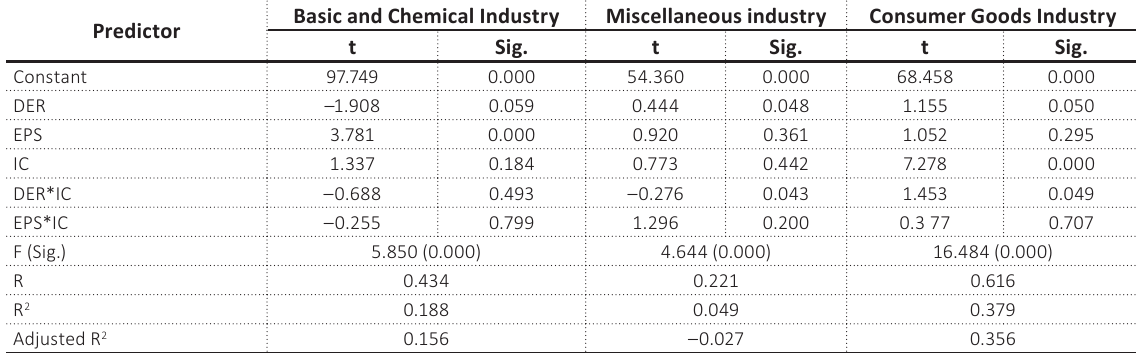
Table 5. Robustness test